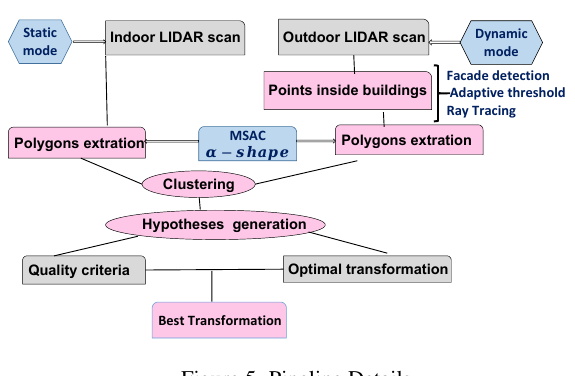
Figure 4. Indoor and outdoor scans acquired in static mode at the Zoological Museum of Strasbourg: blue(outdoor scans), RGB(indoor scans).